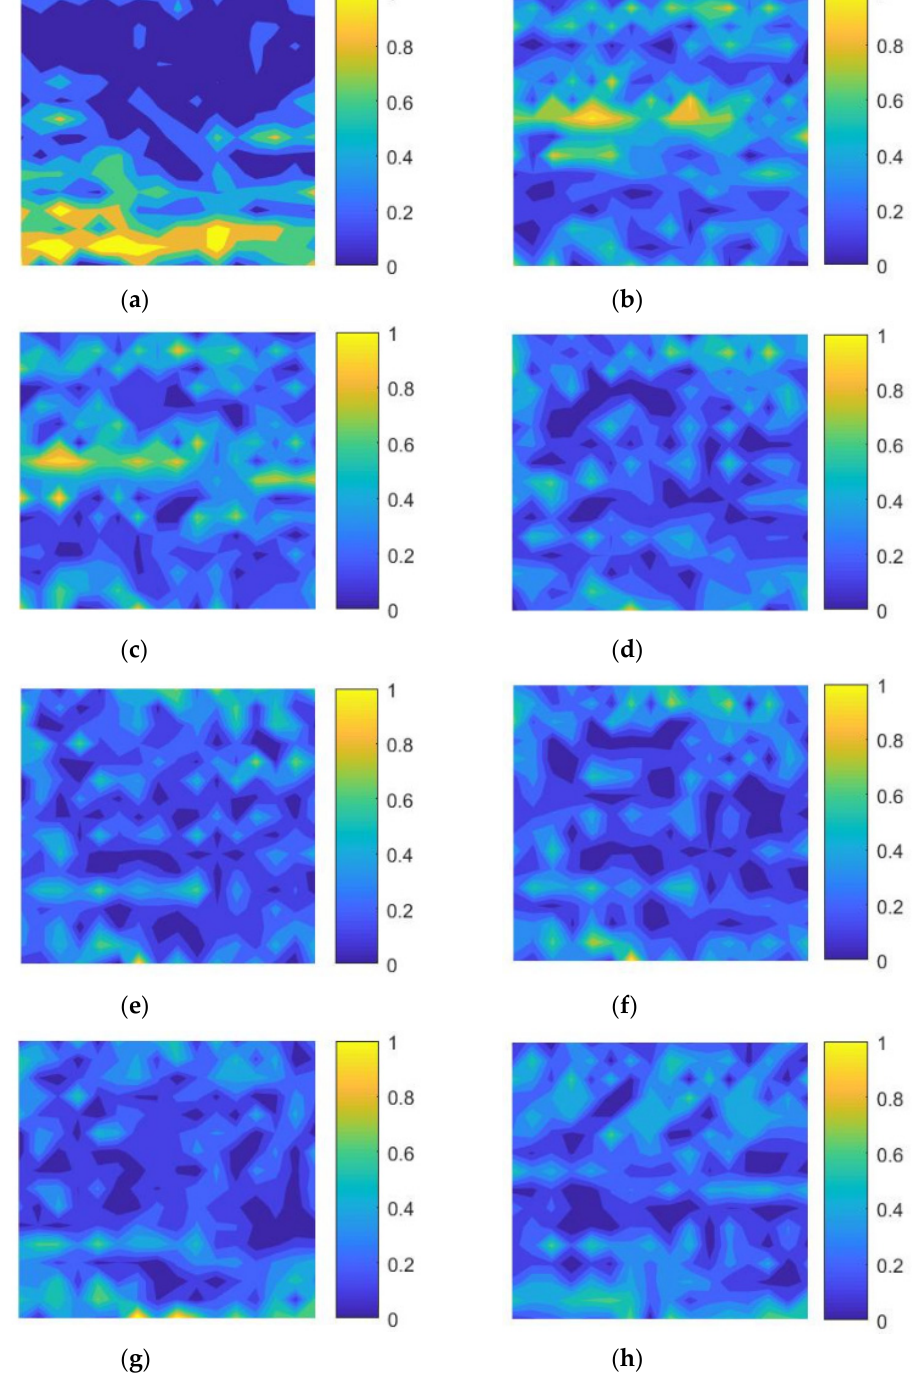
Figure 9. The comparisons of difference between the truth and the correction output. ( a ) Difference between the truth and the forecast; ( b ) difference between the truth and the linear regression result; ( c ) difference between the truth and the SVR result; ( d ) difference between the truth and the LSTM result; ( e ) difference between the truth and the CONVLSTM result; ( f ) difference between the truth and the CONVLSTM-AT result; ( g ) difference between the truth and the 3DCNN-CONVLSTM-AT result; ( h ) difference between the truth and the 3DCNN-CBAM-CONVLSTM-AT result. For SST correction, Zhang et al. [47] proposed a new bias correction model for sea surface temperature in 2020, which used satellite remote sensing data for correction of the numerical forecast model on SST in the South China Sea as well. After being corrected,